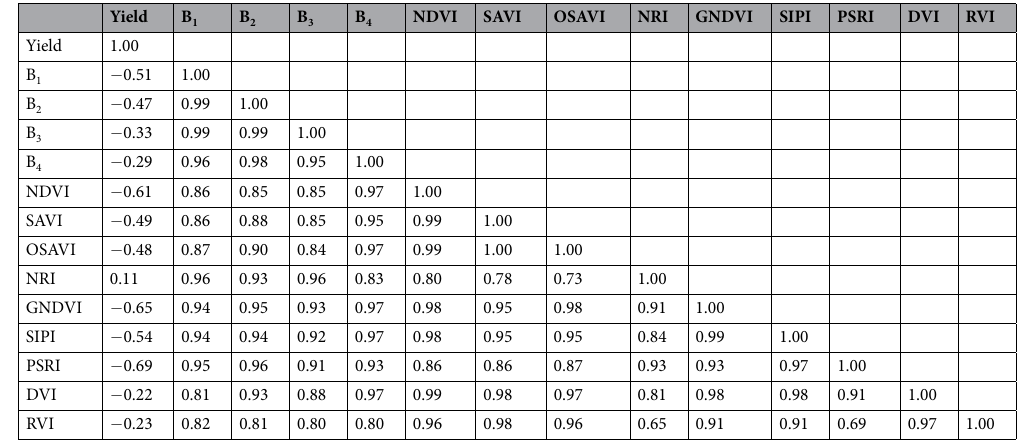
Table 2. Correlation between remote sensing variables and winter wheat yield (n = 159). B1, B2, B3 and B4 denoted spectrum reflectance at blue, green, red and near infrared bands, respectively.